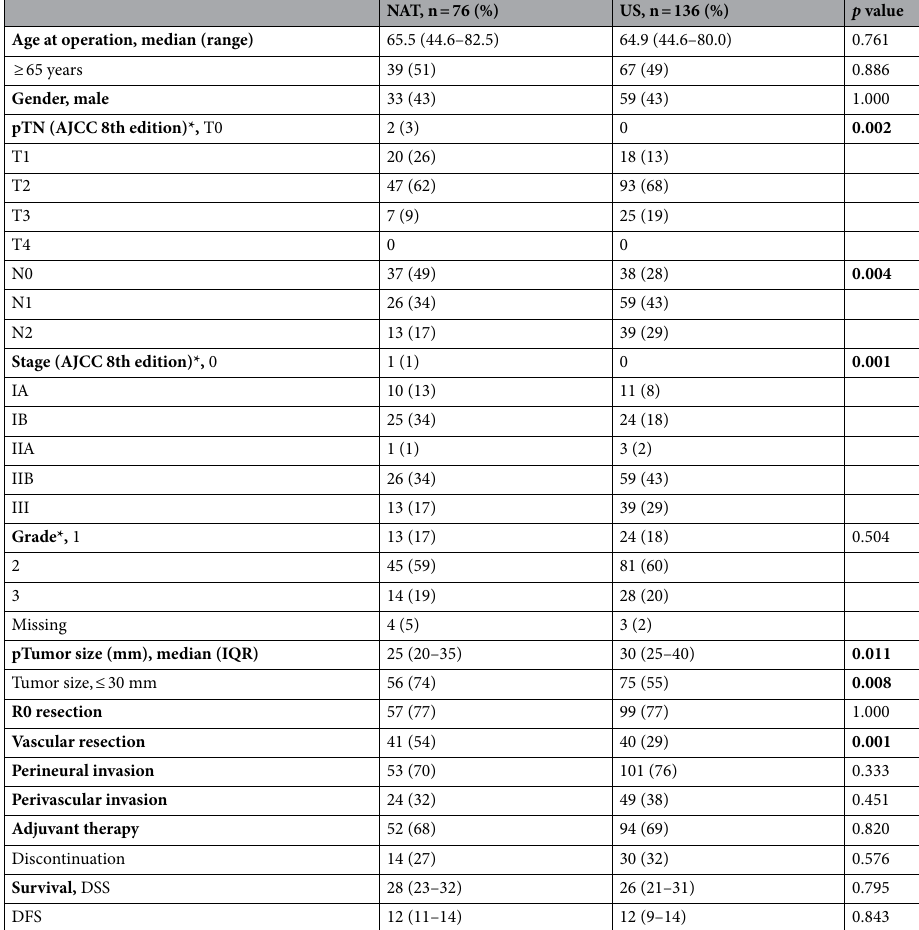
Table 2. Clinicopathological comparison between NAT patients and those undergoing upfront surgery. Missing data: Information on perineural and perivascular invasion was missing in 6 patients. Resection margin status was missing in 9 patients. No tumor grade was available for 7 patients due to a complete response or inconclusive data. The Fisher’s exact and linear-by-linear association (*) were used for categorical variables, while the Mann–Whitney U test was used for continuous variables. AJCC American Joint Committee on Cancer, IQR interquartile range, NAT neoadjuvant therapy, US upfront